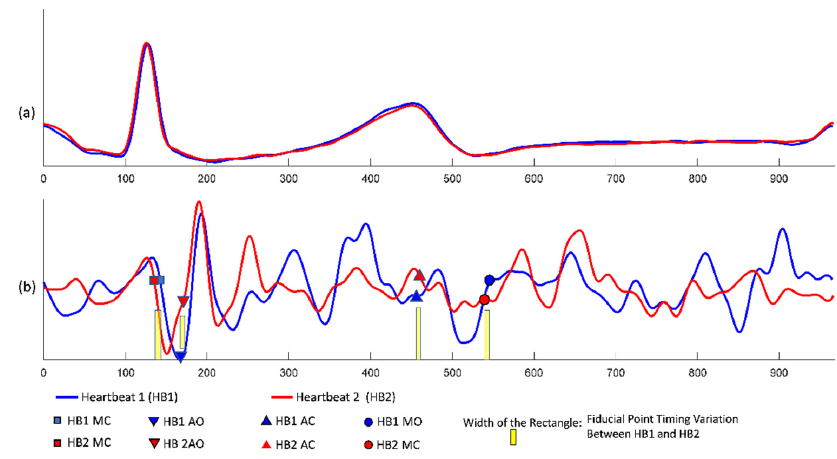
Figure 4. Spontaneous alignment of two ECG and SCG signals with the same heart cycle period: ( a ) ECG signals; ( b ) SCG signals with the detected fiducial points.